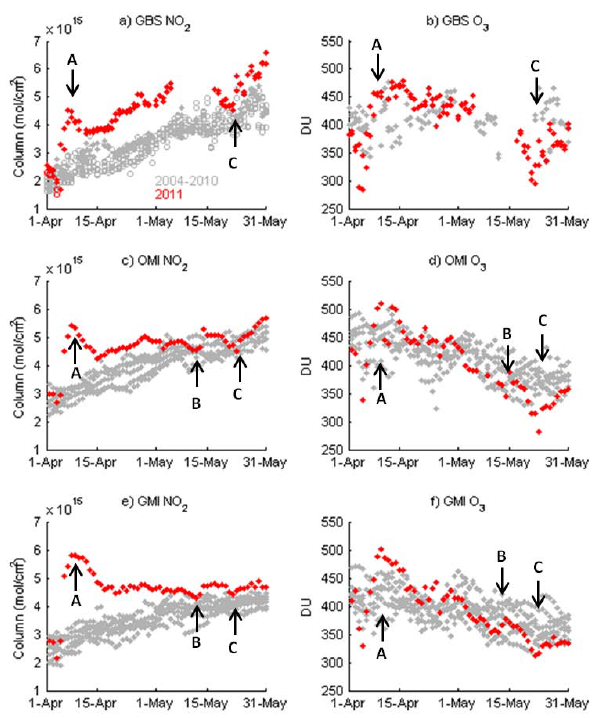
Fig. 1. Timeseries of NO 2 columns (molcm − 2 ) and ozone columns (DU) above Eureka for 1 April to 31 May in 2011 (red) and in 2004–2011 (grey). (a) GBS-vis (closed circles) and GBS-UV (open circles) NO 2 partial columns (17km to top of atmosphere) and (b) GBS ozone total columns, both measured both in morn- ing and evening twilights. (c) OMI stratospheric NO 2 columns and (d) OMI total ozone columns averaged daily within 500km of Eu- reka. (e) NO 2 and (f) ozone total columns from daily GMI out- put from 10:00–10:30a.m. local time at Eureka. Note that there are fewer ozone than NO 2 GBS measurements because, for some years, spring-time dedicated BrO measurements excluded the visi- ble wavelengths used to measure ozone. Black arrows labelled A, B, C indicate 8 April, 13 May, and 22 May,